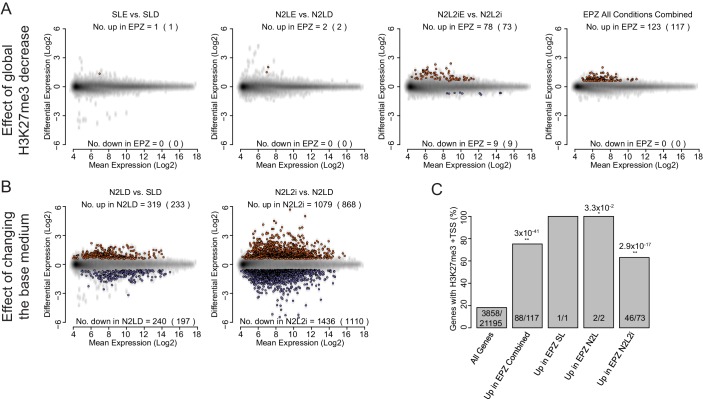
Global expression analysis of ESC following short-term EPZ treatment.(A, B) MA plots generated from microarray experiments comparing (A) the effect of EPZ treatment on ESCs cultured for 24 h in different base medias and (B) the effect of the different base medias themselves within the same timescale. Probes were considered to be up-regulated (red) or down-regulated (blue) if they had a fold change of >1.5 or < 0.67, respectively, and a Benjamini-Hochberg-corrected p-value of <0.05. The number of differentially expressed probes and the number of genes they represent (in parenthesis) are indicated within each plot. (A, B) The conditions indicated are: SL-D (Serum + LIF + DMSO); SLE (Serum + LIF + 2.5 µM EPZ6438); N2LE (N2B27 + LIF + DMSO); N2LE (N2B27 + LIF + 2.5 µM EPZ6438); N2L2i (N2B27 + LIF + 1 µM PD032 + 3 µM CHIR); N2L2iE (N2B27 + LIF + 1 µM PD032 + 3 µM CHIR + 2.5 µM EPZ6438); Combined (all treatments vs. all controls combined at the analysis stage). (C) Barplot representing the percentage of genes with an H3K27me3 ‘peak’ associated with their TSS (± 100 bp). Significance of a differential coincidence of H3K27me3 association vs. ‘All Genes’ was determined using a Fisher’s test and significance is indicated (0.05 >p≥0.01* and p<0.01**) and p values are shown above. Indicated conditions are as for (A, B).